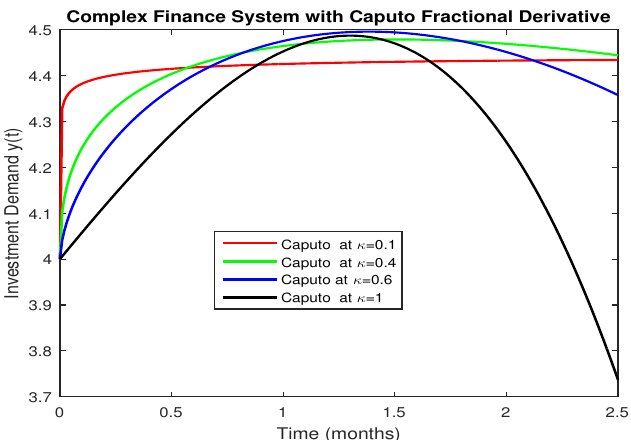
Figure 1. x ( t ) interest rate with Caputo fractional derivative.